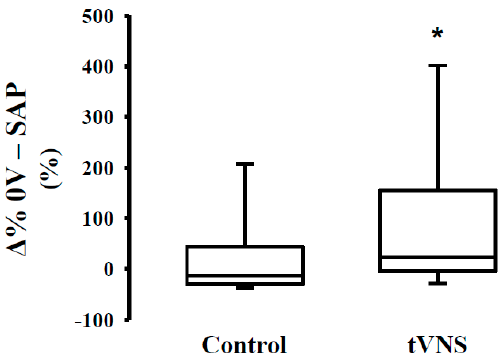
Figure 2. Response ( ∆ %) of peripheral autonomic control to orthostatic stress during transcutaneous vagus nerve stimulation in healthy subjects. Note that the response to orthostatic challenge during tVNS session was higher when compared to the control session. * = difference vs. control, p < 0.05.